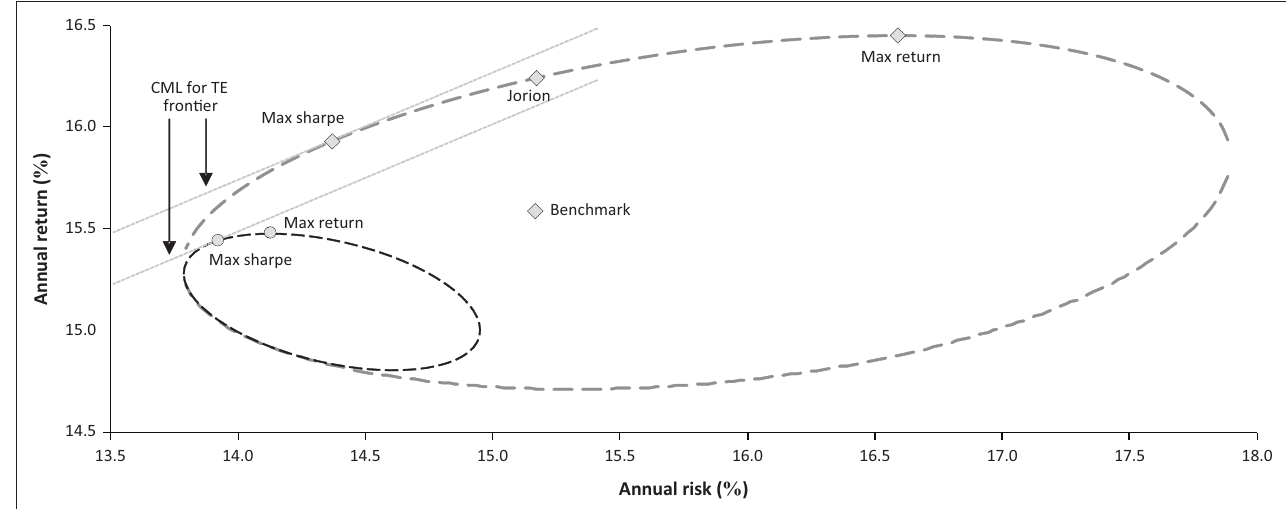
FIGURE 5: Unconstrained (long and short positions permissible) constant tracking error frontier for TE = 5%, sum of domestic weights ∑ foreign weights ∑ w ≤ 95 % , 90 % . Note that, to satisfy these constraints, investment in a ‘risk-free’ asset becomes necessary. i fi